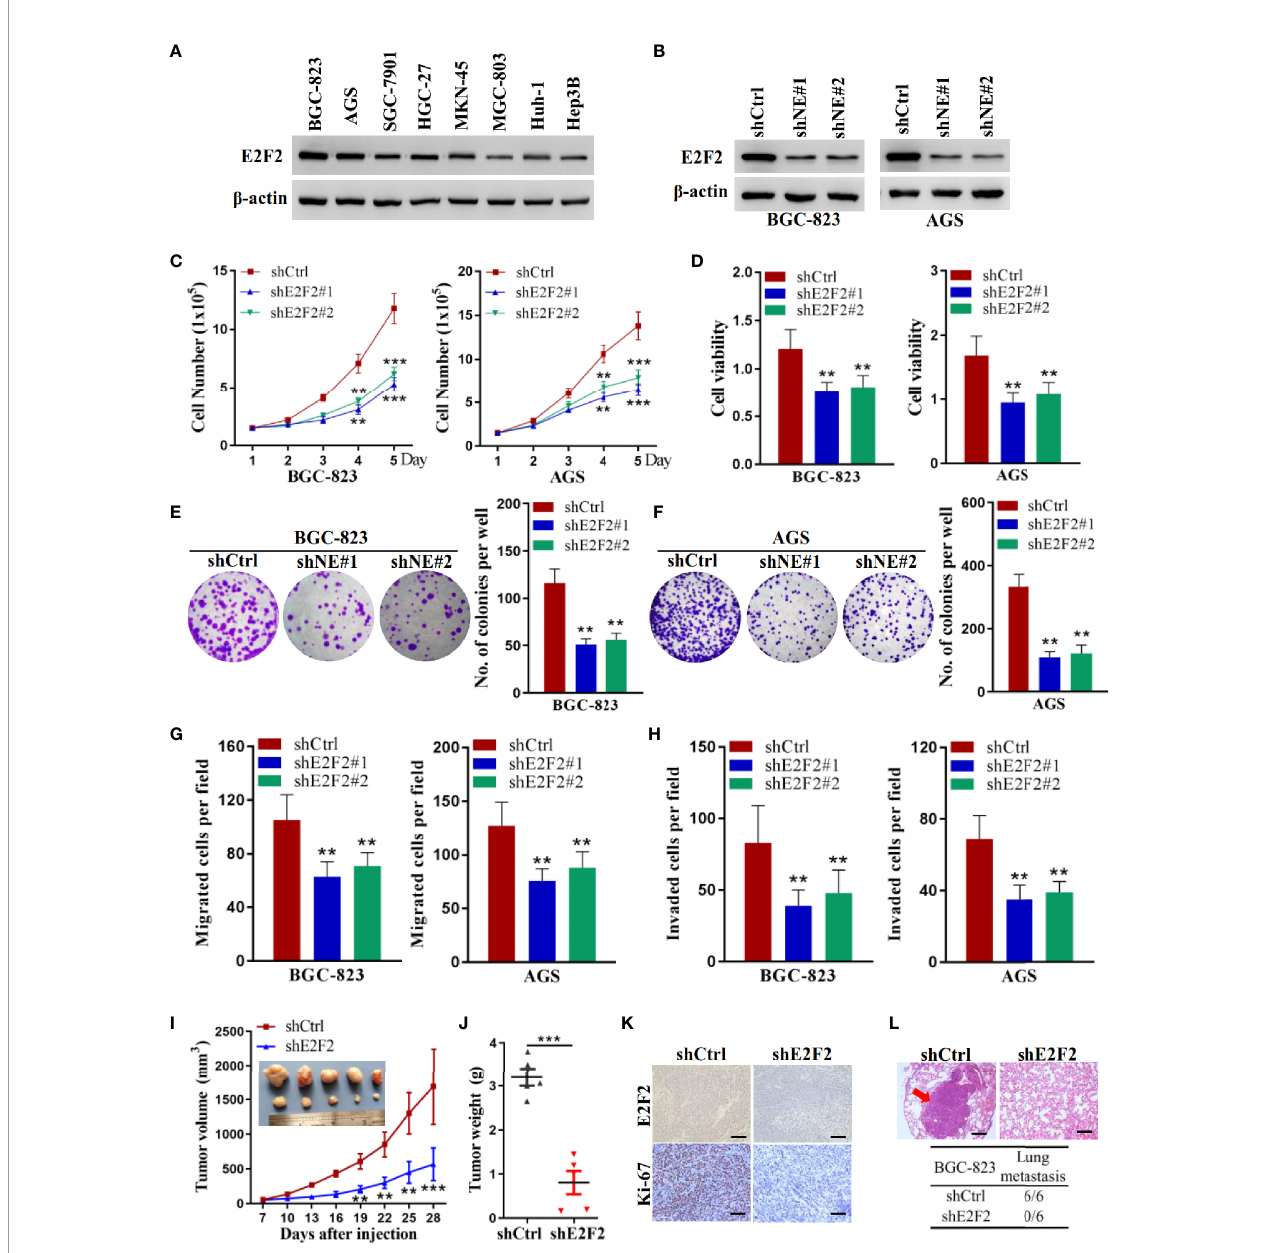
FIGURE 5 | E2F2 promoted the growth and metastasis of human gastric cancer cells. (A) Expression levels of E2F2 were examined by western blot in liver cancer cells (Huh-1 and Hep3B) and gastric cancer cells (BGC-823, AGS, SGC-7901, HGC-27, MKN-45, and MGC-803). BGC-823 and AGS gastric cancer cells were transfected with sh-E2F2#1, sh-E2F2#2, or sh-control. (B) The protein expression level of E2F2 was detected by western blotting. Actin was used as control. (C, D) Cell viability was measured by the MTT assay. (F, G) A cell colony formation assay was performed in BGC-823 and AGS cells. (E, F) A cell colony formation assay was performed in BGC-823 and AGS cells. (G) Transwell migration and (H) invasion assays. (I, J) Five-week-old male nude mice were used in xenograft assays, and BGC-823 cells were mixed with Matrigel and injected subcutaneously into the fl anks. (K) The proportion of ki67-expressing cells in xenograft tumors was examined by immunohistochemical staining. (L) BGC-823 cells were injected into the tail vein. Representative images of H&E staining of lungs and incidence of lung metastasis from mice inoculated with BGC-823 cells. **P < 0.01, ***P <